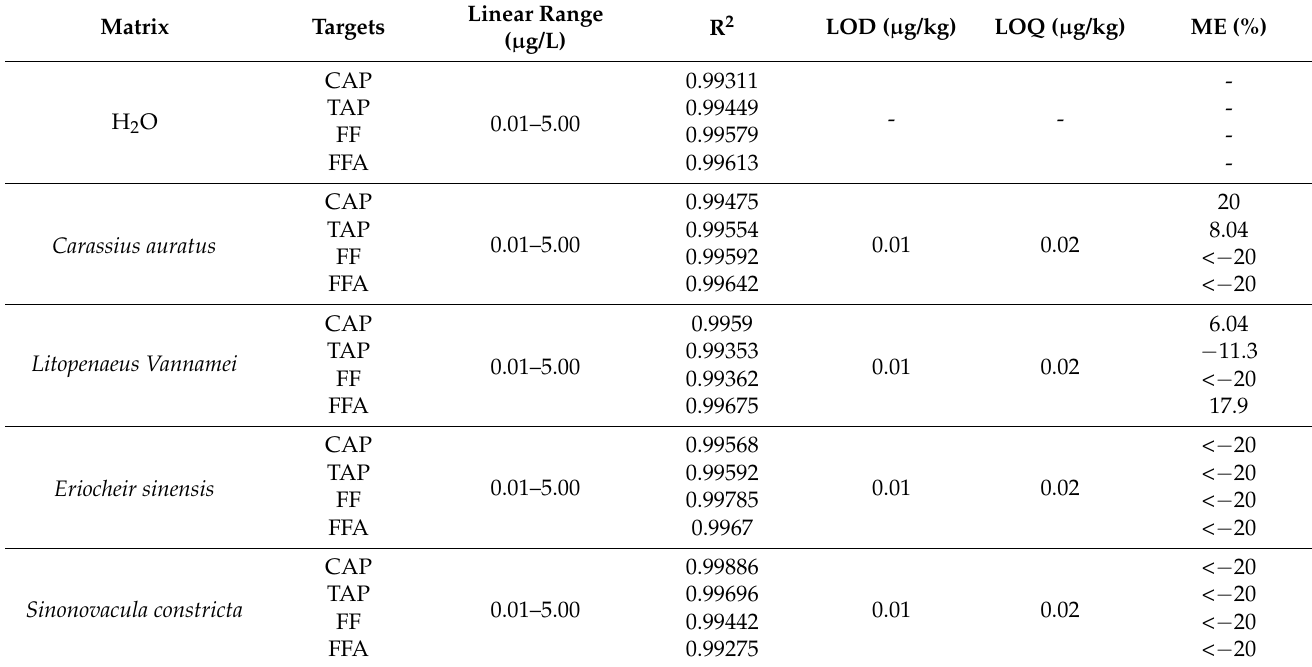
Table 1. Linear range, LOD, LOQ, and matrix effect of CAP, TAP, FF, and